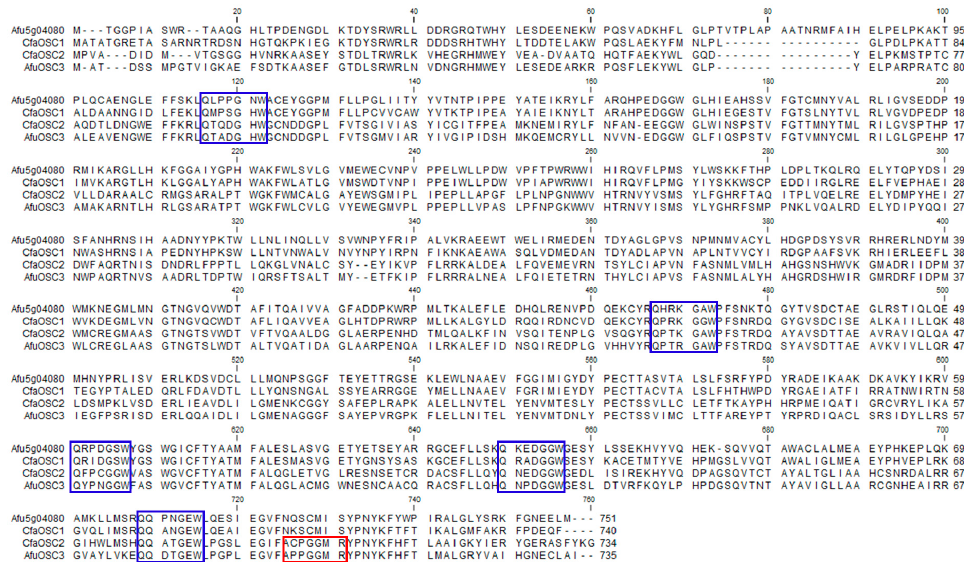
Figure 3. Alignment of amino-acid sequences of OSC genes in Cordyceps farinosa and Aspergillus fumigatus . Blue and red boxes indicate the QW(QXXXGXW) motif and the specific motif that plays a role in protostadienol production, respectively.